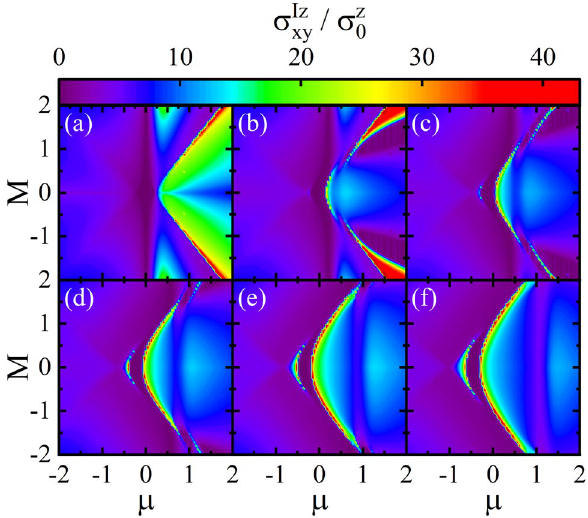
Figure 6. Density plot of the spin conductivity σ Iz xy in the fBA method as functions of the M and µ with the disorder parameter γ b = 0.2 for ( a ) V = 0 , ( b ) V = 0.2 , ( c ) V = 0.4 , ( d ) V = 0.6 , ( e ) V = 0.8 , and ( f ) V = 1 .